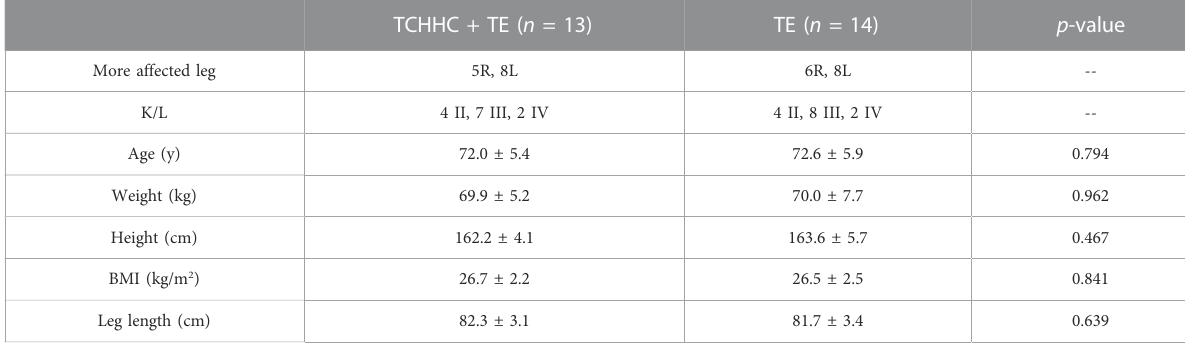
TABLE 2 Demographic characteristics of practitioners.